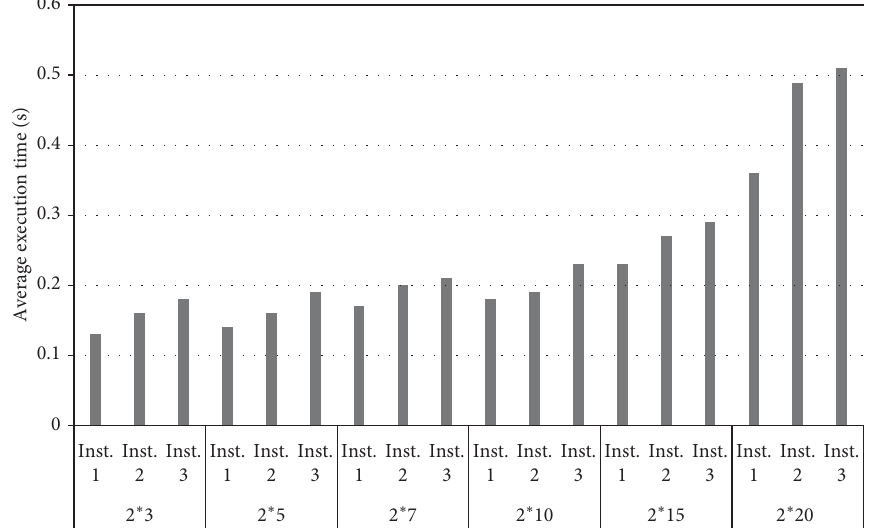
Figure 2: Comparison of average execution times for small problems.